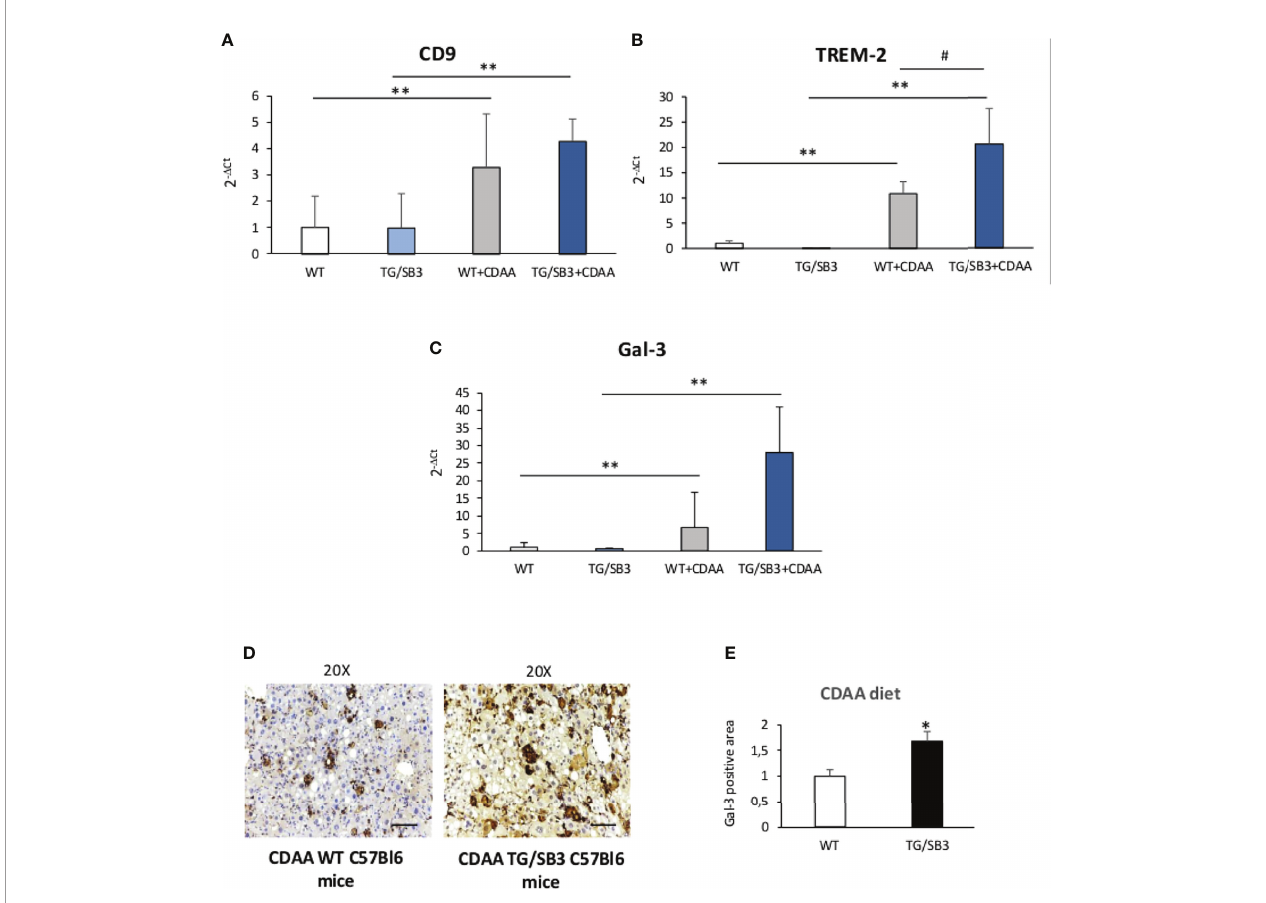
FIGURE 6 | (A – E) Quantitative real time PCR analysis of CD9, (A) TREM-2 (B) and Gal-3 (C) in control C57Bl6J mice and transgenic mice for SB3 fed on control diet (WT and TG/SB3) or CDAA diet for 12 weeks (WT+CDAA and TG/SB3+CDAA). **p < 0.01 versus C57Bl6J control mice fed with control diet (WT) # p < 0.05 versus C57Bl6J control mice fed with CDAA (WT+CDAA). (D) Immunohistochemistry analysis for Gal-3 on liver specimens obtained from C57Bl6J WT mice and transgenic mice for SB3 (TG/SB3) fed on CDAA for 12 weeks. Magni fi cation 20x, scale bar 100µm. (E) ImageJ software analysis was performed to evaluate the amount of Gal-3 positive area in C57Bl6J WT mice and transgenic mice for SB3 (TG/SB3) fed on CDAA for 12 weeks. *p < 0.05 versus WT